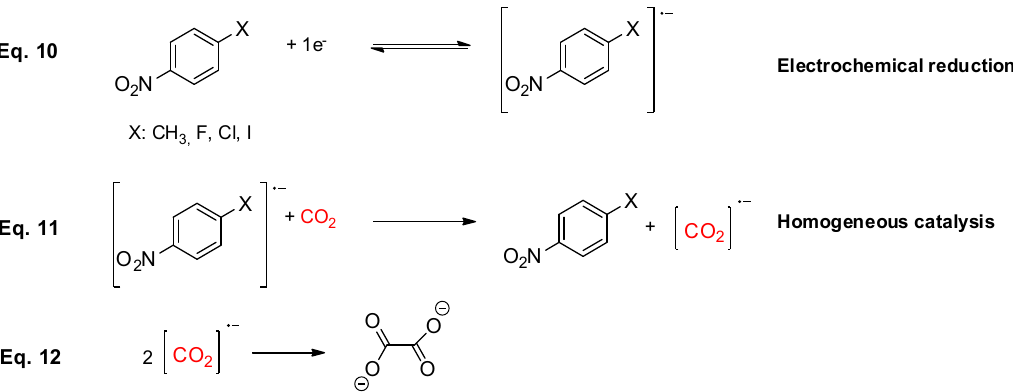
Figure 3. Cyclic voltammetry of 10 mM p -nitro compounds 1 - 4 with Ag (black line), Cu (red line) and C (blue line), under CO 2 atmosphere. Scan rate: 0.5 V·s −1 . Solution of DMF/0.1M TBA BF 4 (left) and solution of 3 mL EMIM TFSI (right).